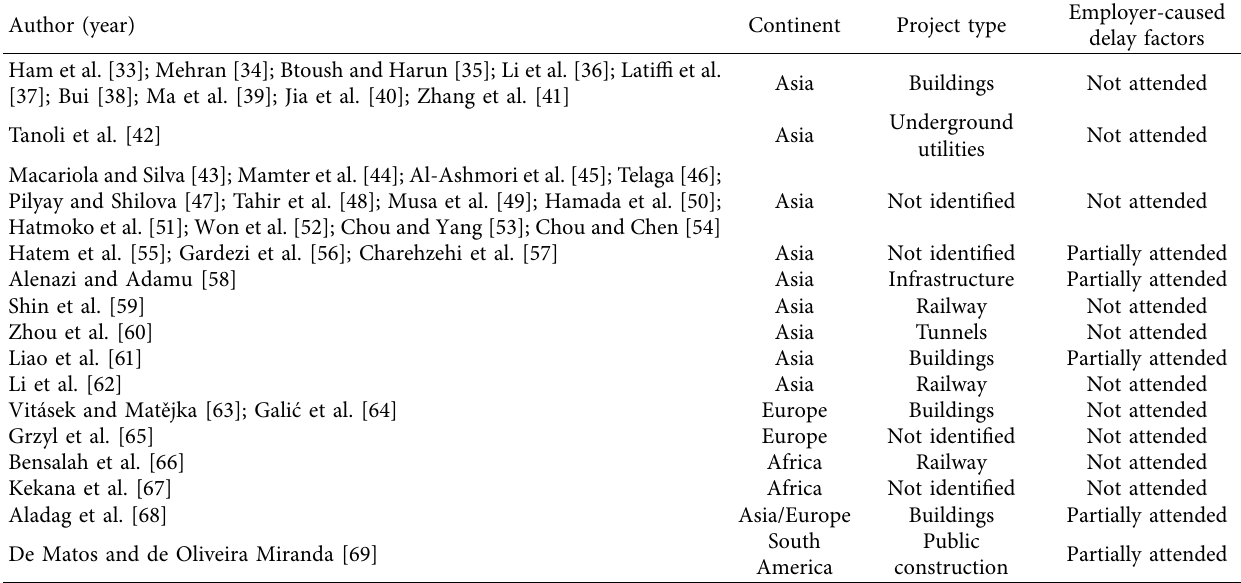
Table 4: Employer-caused delay factors in previous BIM